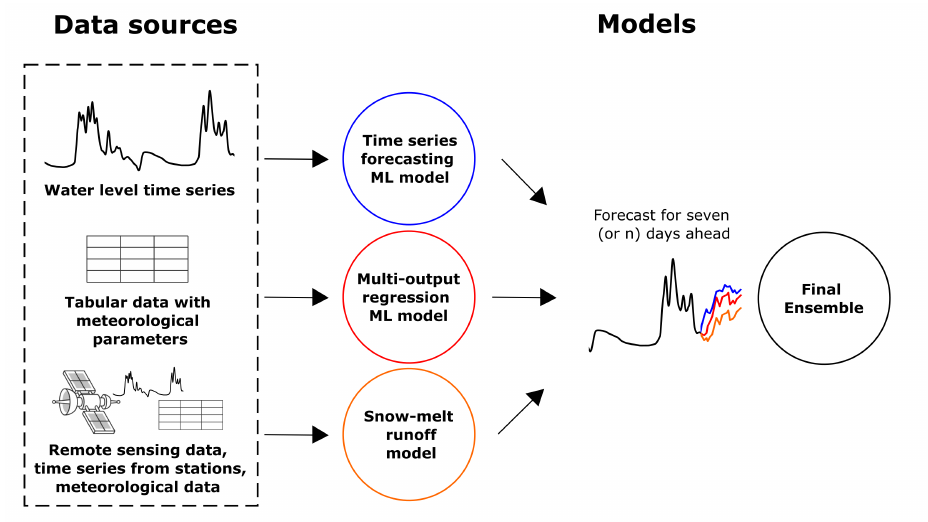
Figure 3. Data processing scheme in the composite pipeline. The ensemble consists of three models, each of which is trained and calibrated on separate data